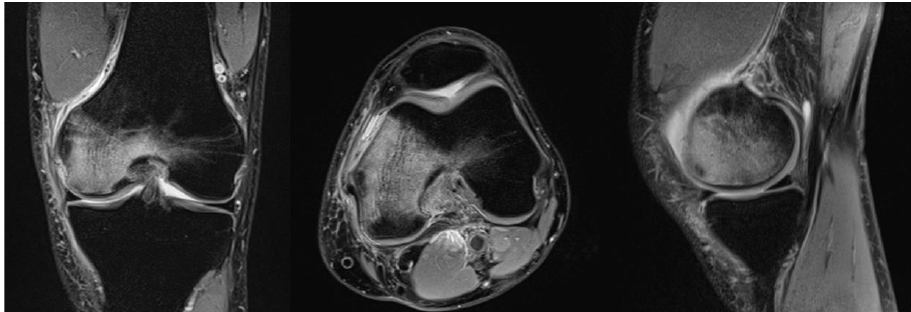
Figure 1. MRI of a right knee in a 51-year-old man showing osteonecrosis of the femoral condyle. MRI is useful in confirming the size of the lesion initially measured on the X-ray by assessing parameters of width, depth and height of the lesion in the coronal and sagittal sections of the MRI